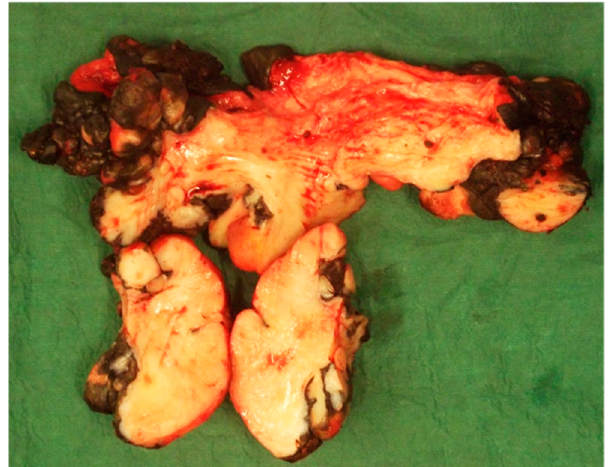
Figure 16. Appearance of the preputial mass after resection (clinical case 3).